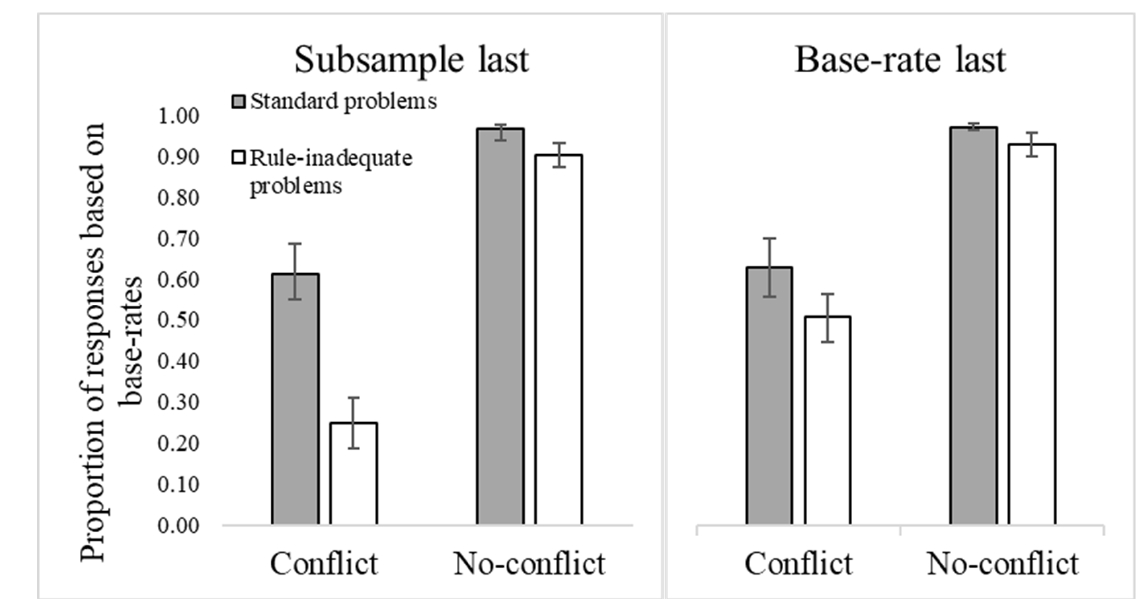
Figure 6. Proportion of correct responses to no-conflict problems and base-rate responses to the standard and rule-inadequate versions of conflict problems in both orders of information presentation (Experiment 4).